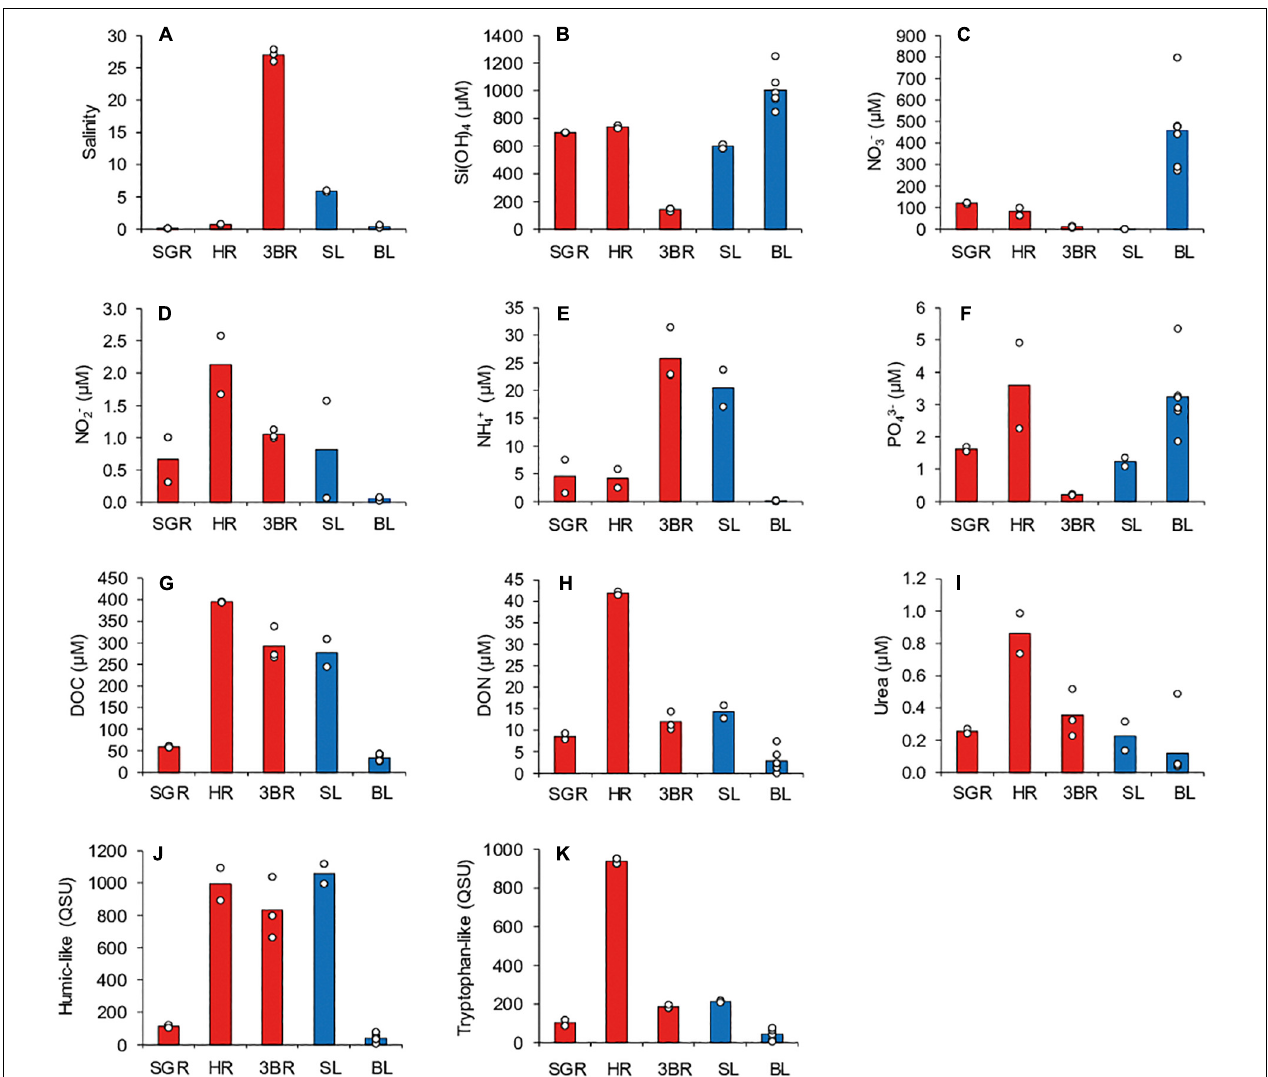
FIGURE 2 | Salinity and biogeochemical parameters for freshwater samples (rivers, in red and groundwater, in blue) (A–K) . Histograms represent mean values while dots represent individual sample values. SGR: Saint Gilles River, including SGR1, two samples; HR: Hermitage River, including HR1, two samples; 3BR: Trois-Bassins River, including 3BR1-three samples; SL: Sand layer groundwater, including SL1, two samples; BL: Basalt layer groundwater, including FH, FM, BL1-3, and TE samples.